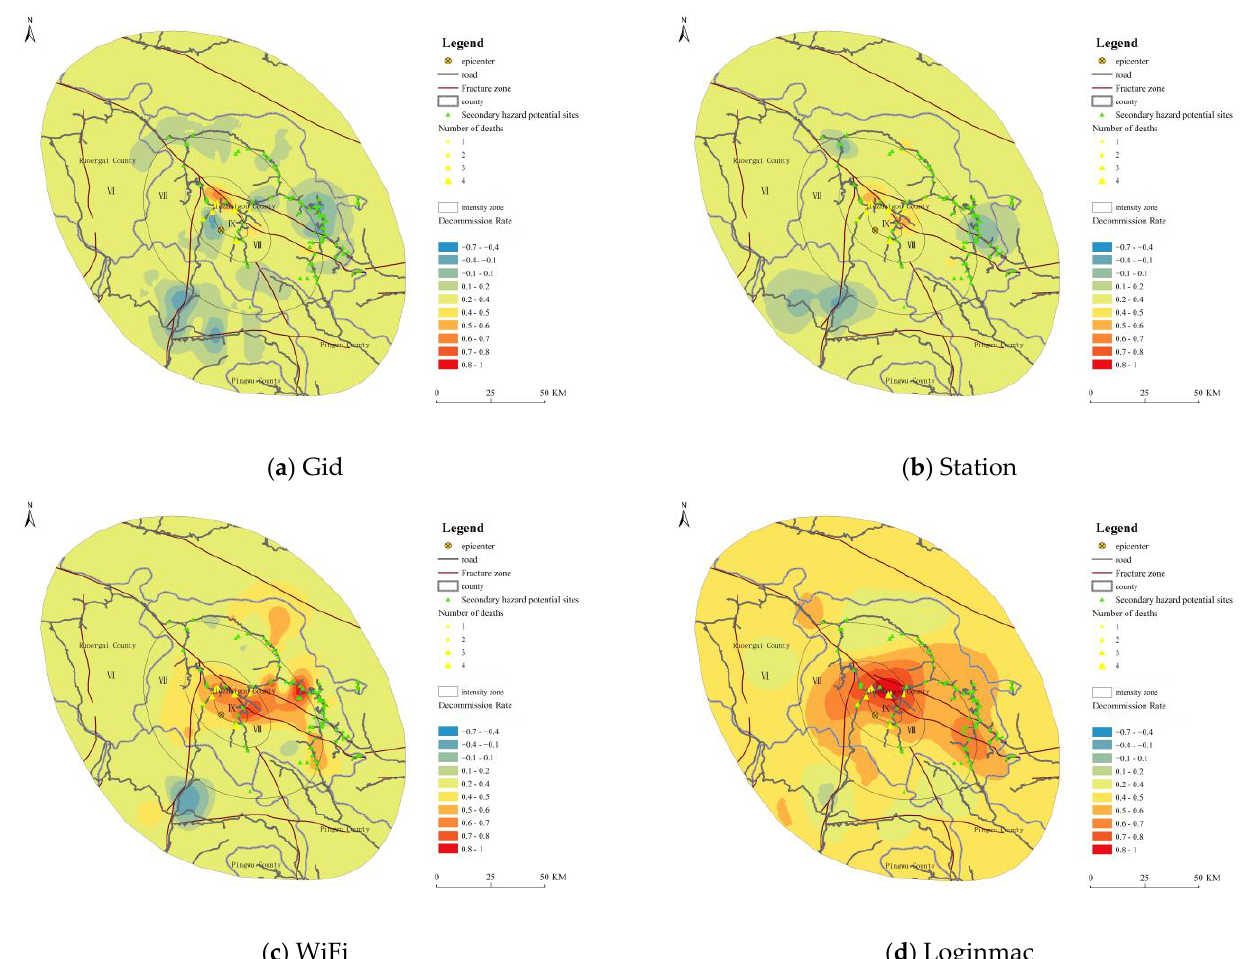
Figure 6. Interpolation results of the decommission rate.